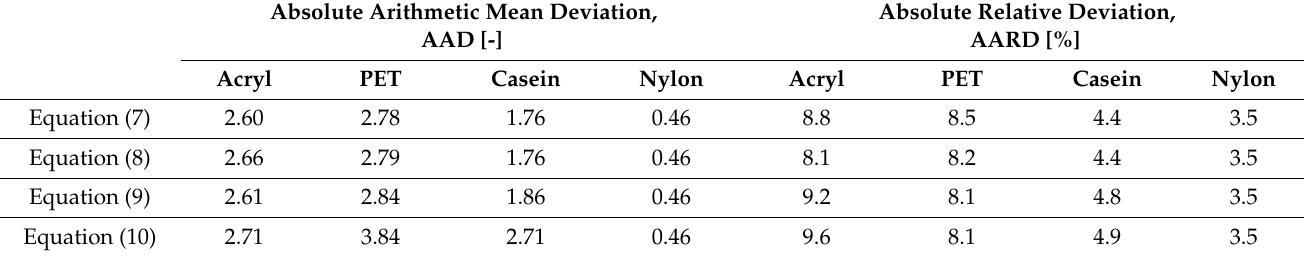
Table 3. Absolute arithmetic mean deviation and relative mean deviation for K / S by Equations, (7); to, (10).